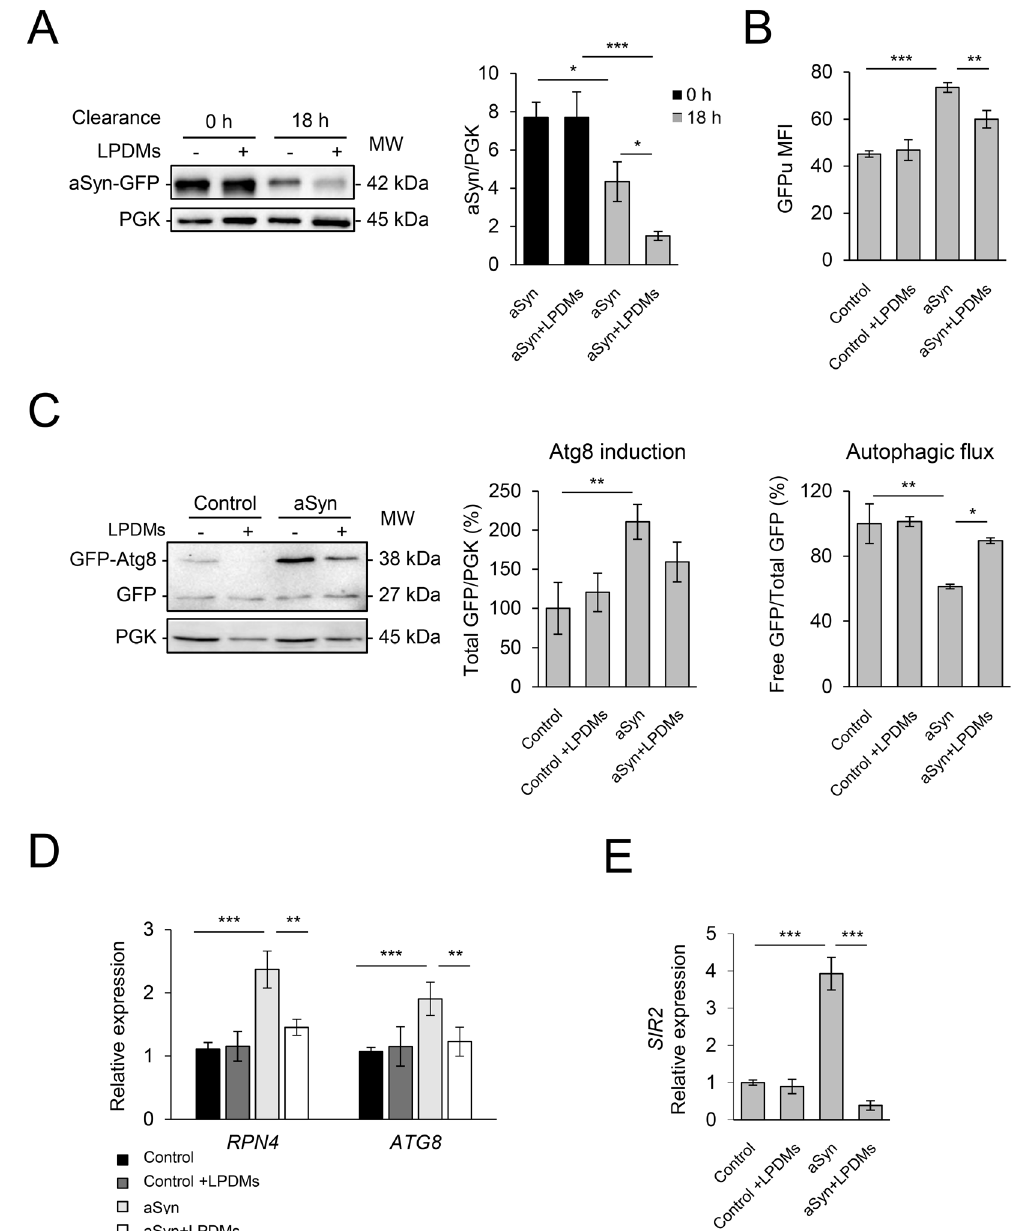
Figure 3. A. unedo LPDMs increase the clearance of aSyn by promoting autophagy and proteasomal function. Yeast cells were treated with 62 μ g GAE.mL − 1 of LPDMs for 6 h, in galactose medium. ( A ) Clearance of aSyn evaluated by western blot at 6 h of aSyn induction (0 h clearance) and after18 h in glucose medium (18 h of clearance) (left panel), and respective quantification normalized to PGK levels used as loading control. ( B ) Proteasome impairment evaluated by flow cytometry (FCM) using GFPu median fluorescence intensity (MFI), after 6 h of aSyn induction. ( C ) Autophagy evaluated by GFP-Atg8 processing assay assessed by western blot (left panel), after 6 h of aSyn induction. Atg8 induction quantified by the total GFP signal (GFP-Atg8 and free GFP signal, detected with anti-GFP) (middle panel); autophagic flux quantified by measuring the vacuolar degradation of the Atg8 domain reporter (ratio of free GFP to total GFP signal) (right panel). ( D ) RPN4 and ATG8 gene relative expression levels assessed by qRT-PCR. ( E ) SIR2 relative expression levels assessed by qRT-PCR. A representative result is shown, and values represent the mean ± SD of at least three independent experiments. Statistically significant differences between the indicated treatments are shown, * p <